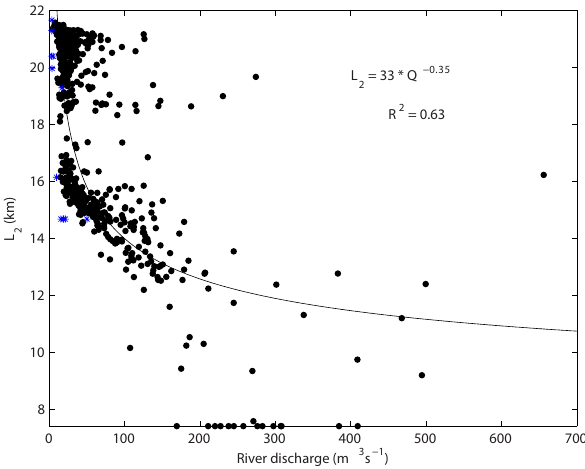
Fig. 7. Length of saline intrusion ( L 2 =length of bottom salin- ity > 2psu) against river discharge; * represent field data interpo- lated along the thalweg from monthly samples taken at 5–6 discrete stations.